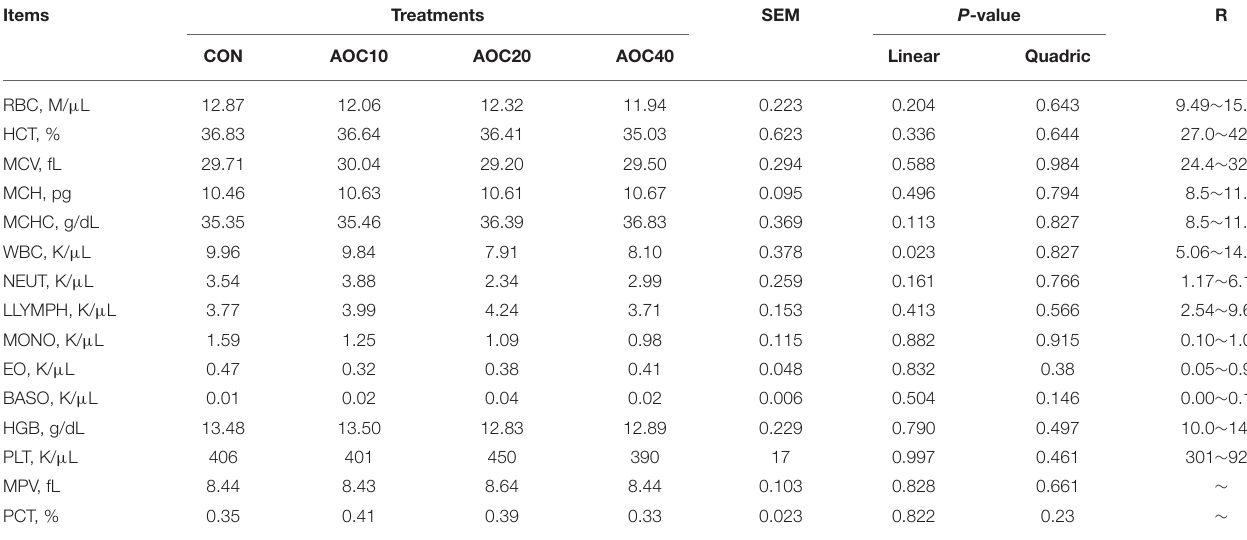
TABLE 8 | Effects of different dietary levels of Aspergillus oryzae culture on blood cell count of Hu sheep. Items Treatments SEM P -value R CON AOC10 AOC20 AOC40 Linear Quadric